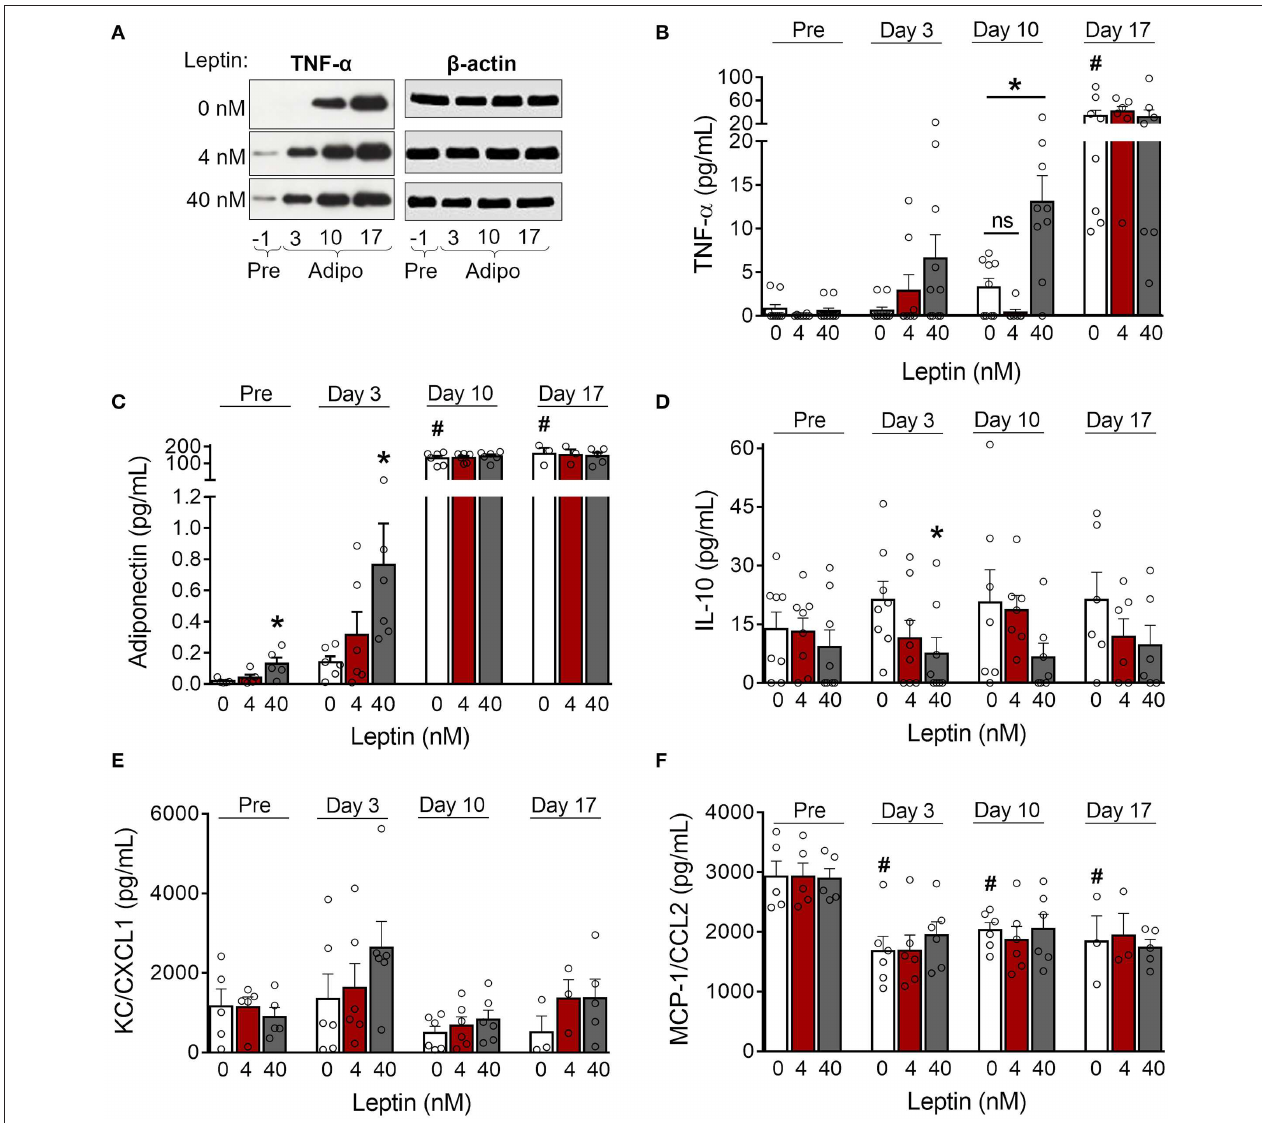
FIGURE 3 | Leptin induces a proinflammatory cytokine profile during adipocyte differentiation. (A,B) 3T3-L1 preadipocytes (day − 1) and adipocytes at days 3, 10, and 17 were cultured in the presence of leptin (0, 4, or 40nM). (A) Western blot analysis of TNF- α and β -actin in cell lysates from each condition. Blots are representative of three independent experiments. Cell lysates from a representative experiment were analyzed in the same gel and cropped for clearer comparison among the groups. (B–F) Concentration of (B) TNF- α , (C) adiponectin, (D) IL-10, (E) KC/CXCL1, and (F) MCP-1/CCL2 in the supernatant of preadipocytes and adipocytes differentiated under distinct leptin stimulus. Bars represent mean ± standard error of the mean of 3–11 independent experiments. # p < 0.05 compared to preadipocytes (day − 1). *Represents p < 0.05 between leptin-treated and untreated cells at the same stage of differentiation. Statistical analyzes were performed by using (B–E) One-way ANOVA followed by Kruskal-Wallis’ test with Dunn’s correction or (F) One-way ANOVA with Dunnet’s post-test. “ns” stands for non-significant.